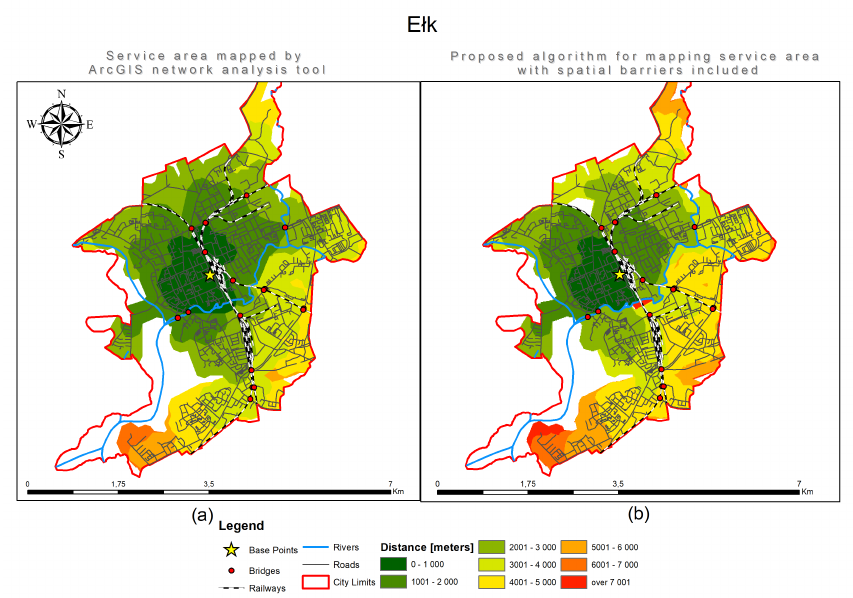
Figure 9. Service areas identified in the city of Ełk: ( a ) results generated by the standard network analysis tool in ArcGIS; ( b ) results generated by the algorithm developed in the ModelBuilder application in ArcGIS.